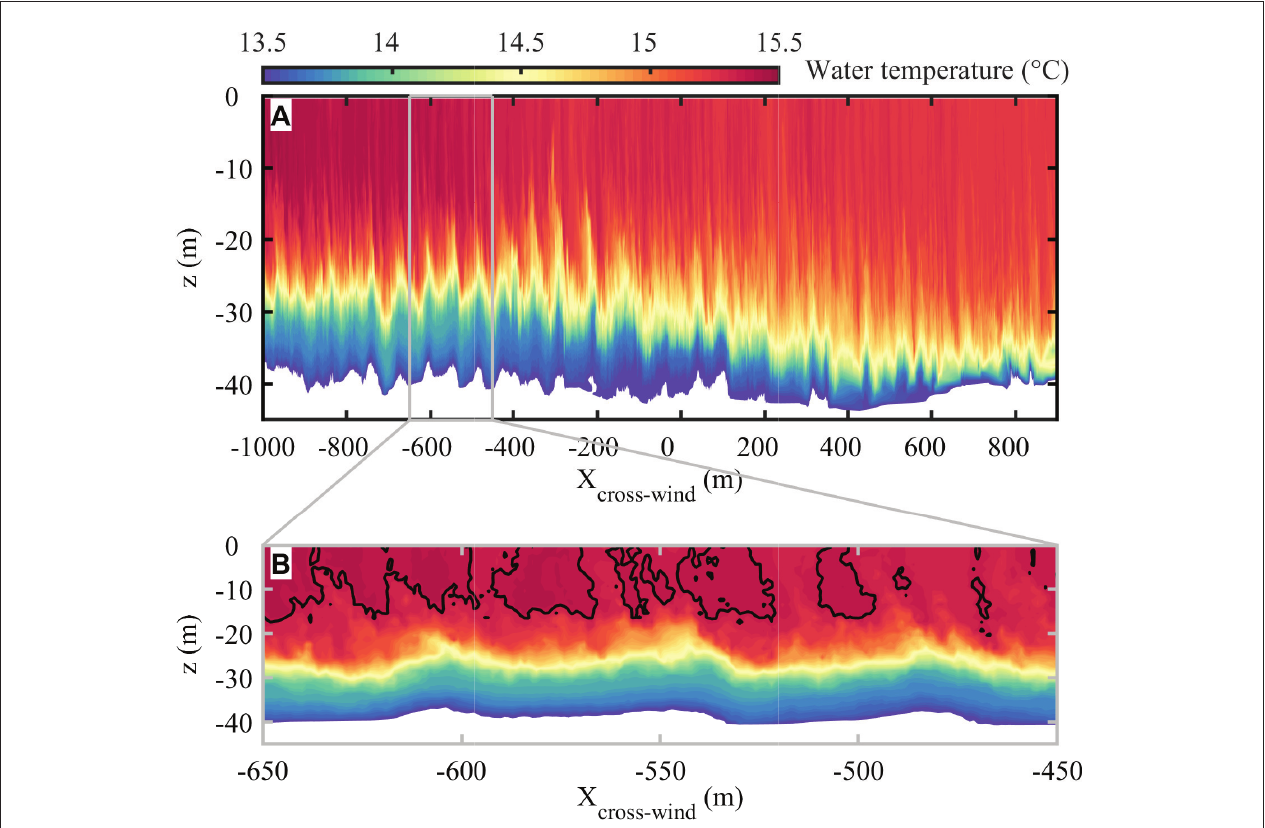
FIGURE 9 | Water temperature profile map along a crosswind transect highlighting the presence of Langmuir cells during LCDRI2017 from the SV2 Wave Glider Kelvin . The transect started at 0633 UTC 23 March 2017 and was completed in 4 h and 39 min. (A) Colored map of the water temperature profiles along the entire 1,900 m long transect. (B) An enlarged 200 m long portion of the transect with the same color scale and additional black contours representing the temperature level at 15.37 ◦ C. This isotherm highlights the presence of quasi circular cells in the first 10–15 m of the OBL which are distinctive features representative of Langmuir